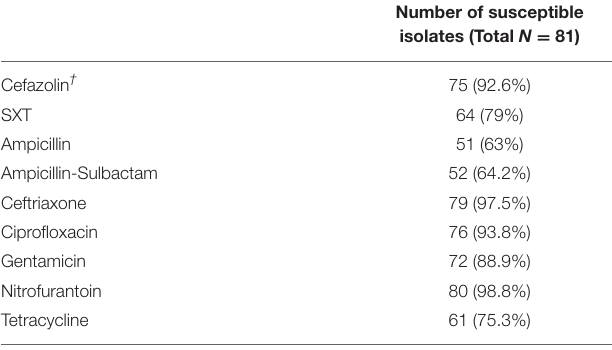
TABLE 3 | E. coli susceptibility to antibiotics across all age groups.